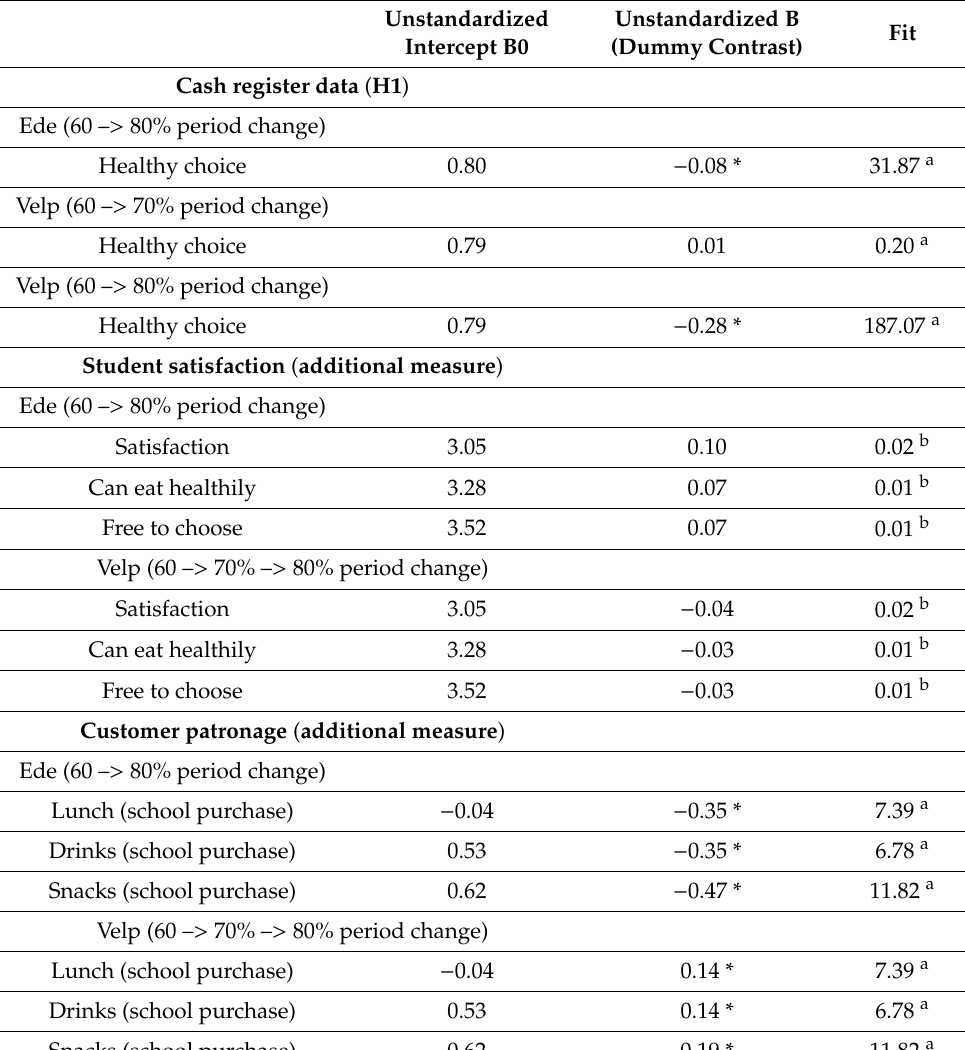
Table 5. Regression results hypothesis 1 and additional